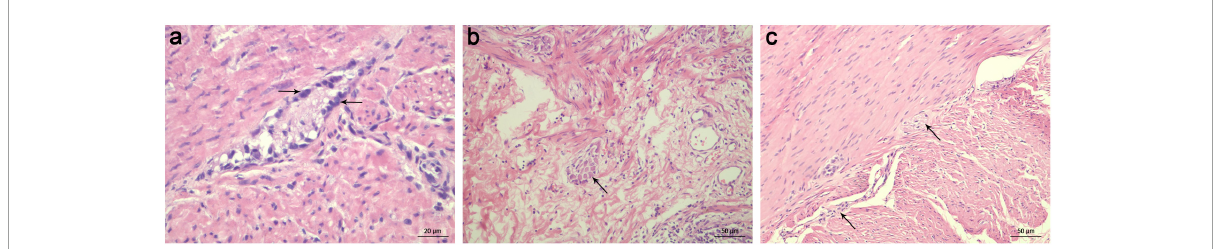
FIGURE4 HE staining of ganglion cells in the proximal bowel with barium retention. (a) Immature ganglia were identified in the proximal level of barium retention. The ganglion cells appear small and have a less significant nucleus with an inconspicuous nucleolus (indicated with black arrows). scale bar = 20 µ m. (b) Neuronal dysplasia was found in the proximal level of barium retention, described as increased frequency of “giant” submucosal ganglia (indicated with black arrows). scale bar = 50 µ m. (c) Myenteric hypoganglionosis in the proximal level of barium retention was characterized by widely spaced small ganglia with only 1–2 ganglion cell bodies (indicated with black arrows) using HE staining. scale bar = 50 µ m. HE, hematoxylin-eosin.